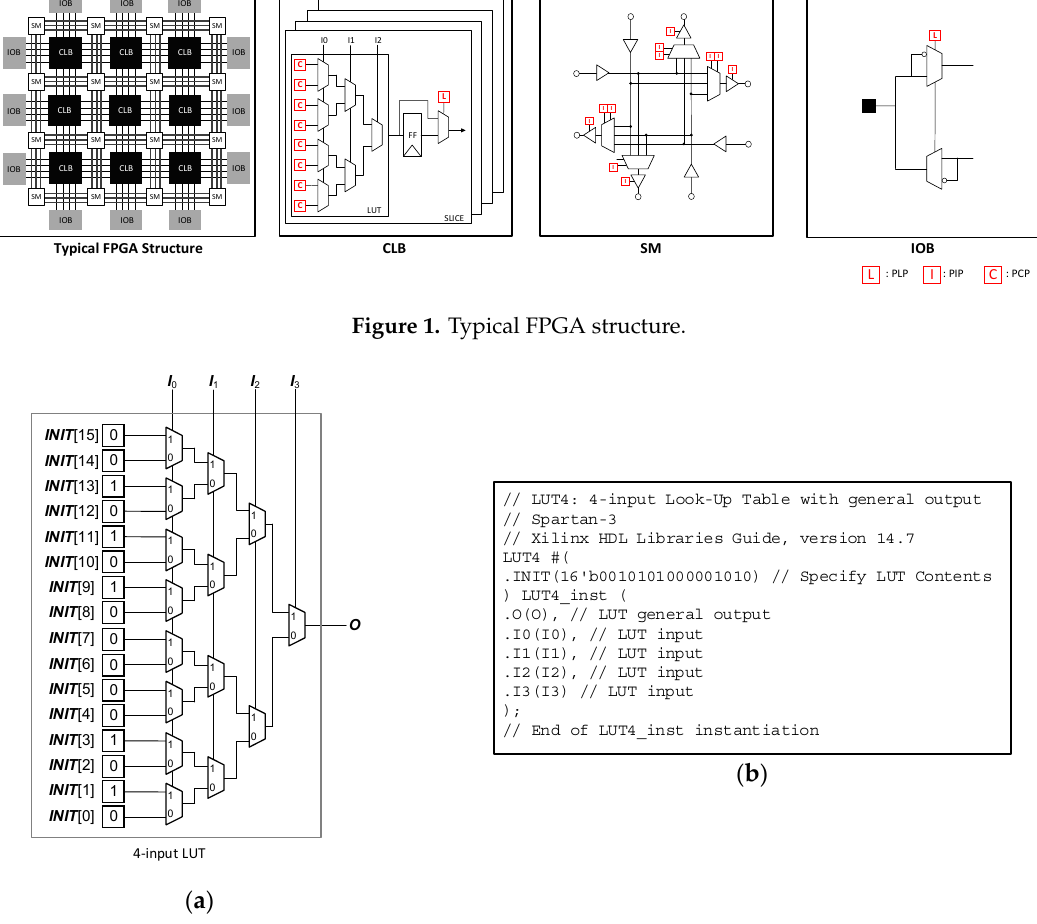
Figure 2. ( a ) Structure and ( b ) primitive library for 4-input LUT.